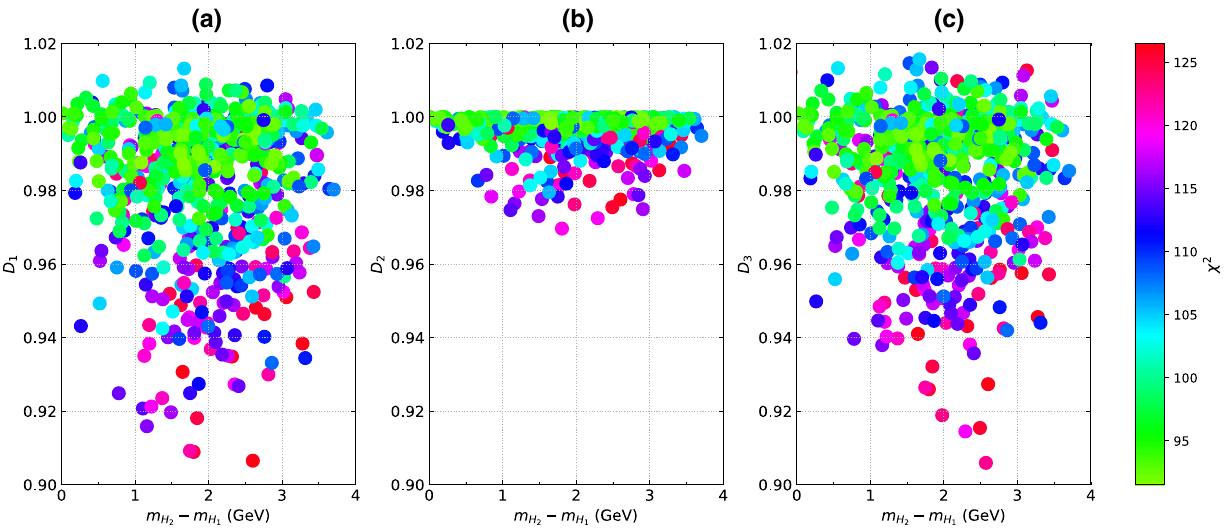
− m H 1 . The color-bar in all the panels corresponds 2